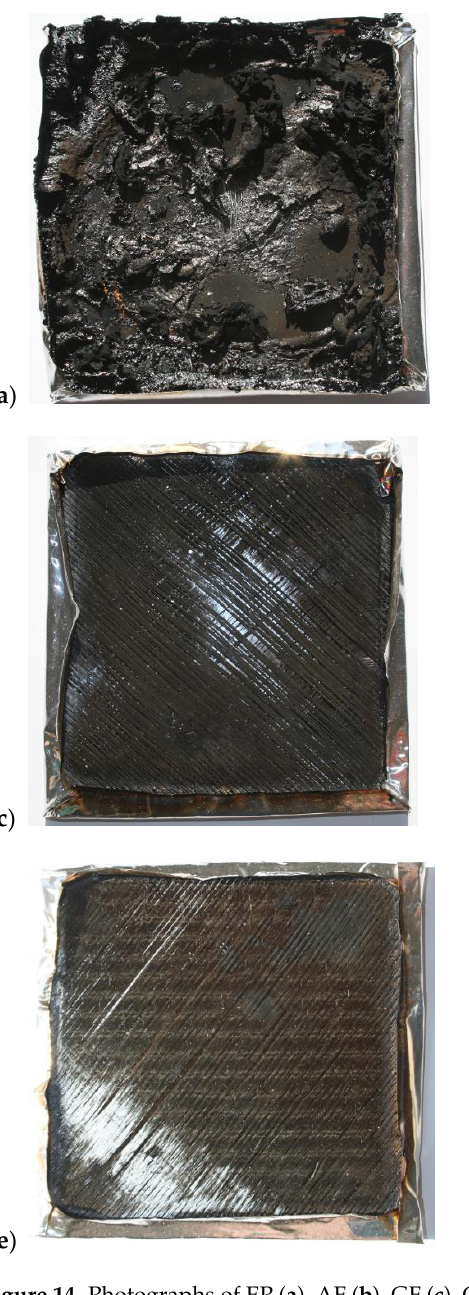
Figure 14. Photographs of EP ( a ), AF ( b ), GF ( c ), CF ( d ), BF ( e ), FF ( f ) after cone calorimeter (CC) tests.